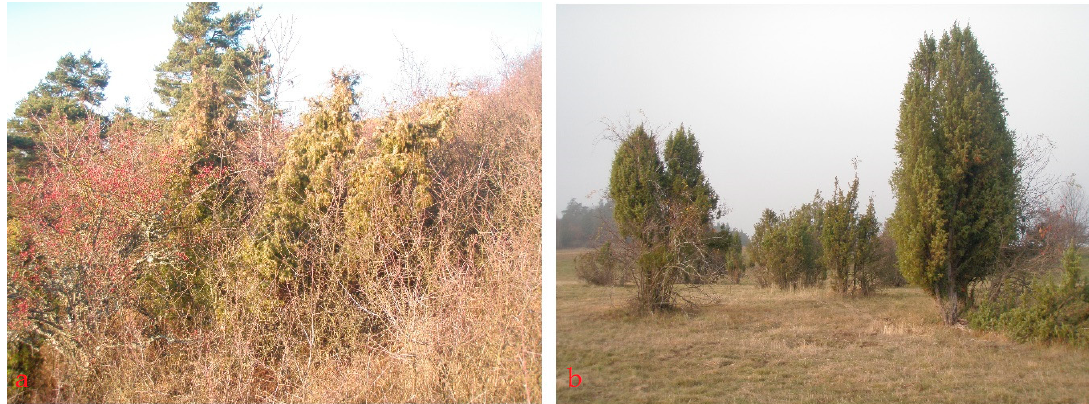
Figure 4. Junipers overgrown by Prunus spinosa and Rosa spp. ( a ), and a juniper habitat regularly maintained by grazing at the Vrbi č ka locality ( b ) .